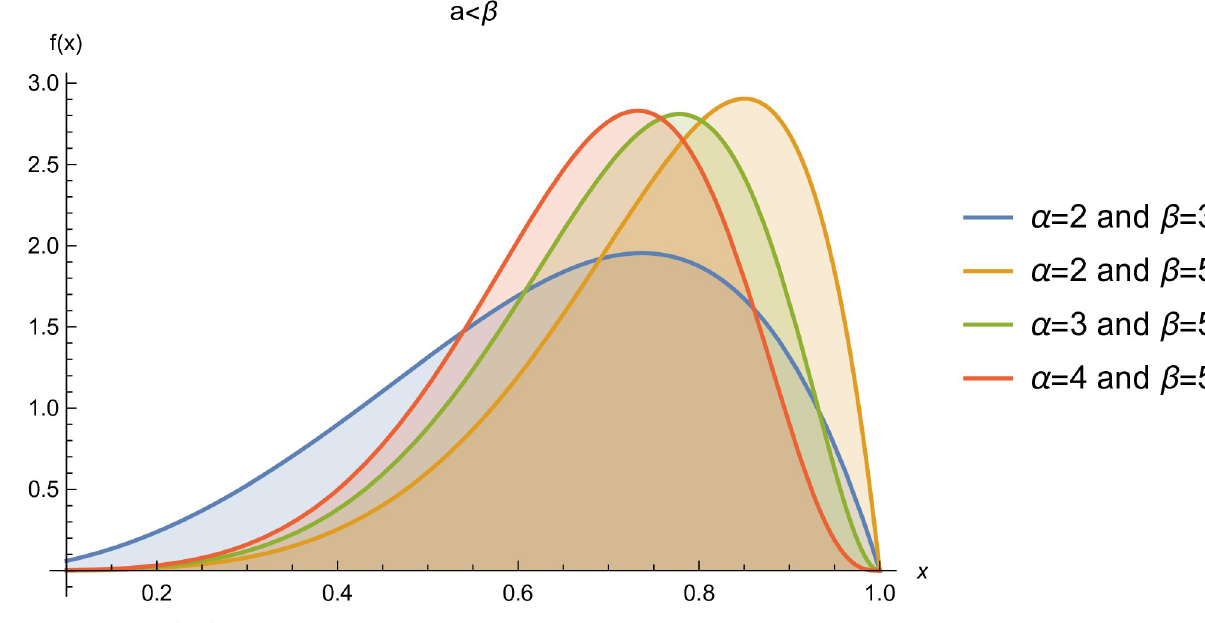
Fig 2. pdf of Kum ( α , β ), when α < β .